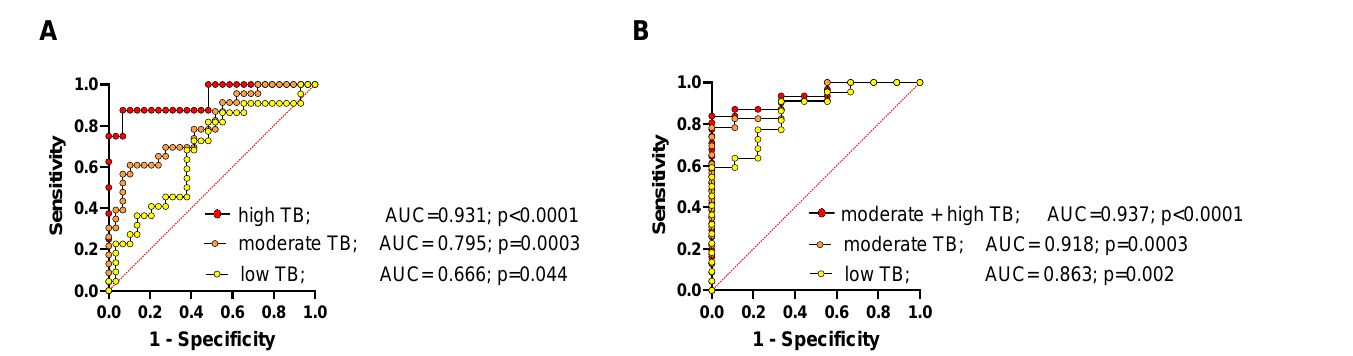
Figure 6. Multiparametric ROC analysis using cfDNA concentration, percentage of Alu hypomethylation, and LINE-1 integrity to estimate the strength of the model to discriminate between ( A ) healthy controls and NEN patients or ( B ) presumably cured NEN patients and patients with low, moderate, and high tumor burden (TB), along with the area under the curve (AUC), for sensitivities and specificities see Table S3 in the Supplement.